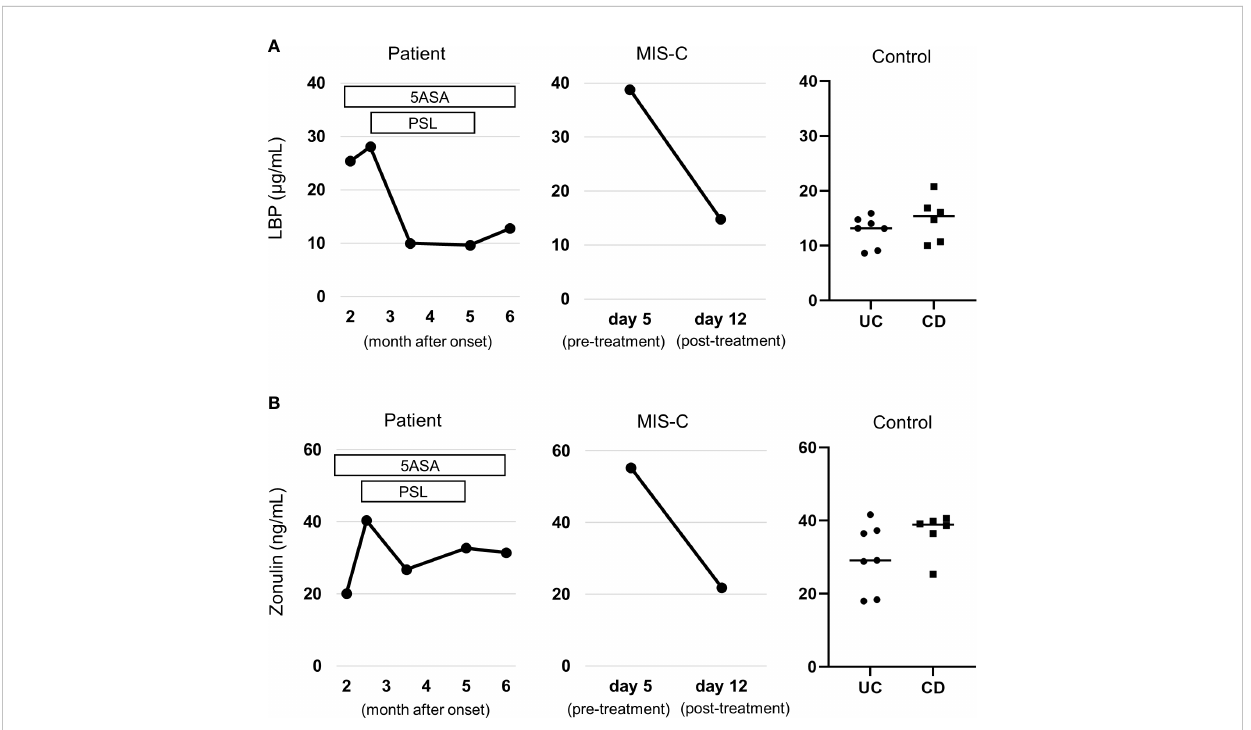
FIGURE 2 Serum gut permeability markers. (A) Changes in serum zonulin. (B) Changes in serum lipopolysaccharide binding protein (LBP). Levels of both markers were compared to those patients with MIS-C as positive control (see reference (13) for details on the clinical course) and patients with in fl ammatory bowel disease in remission as negative control. Note that the patient did not have elevated zonulin through the clinical course, but had elevated LBP, which was normalized by steroid therapy. They were measured by a zonulin (serum) ELISA kit (Immundiagnostik, Bensheim, Germany) and an LBP ELISA kit (Hycult Biotech, Wayne, PA, USA), respectively. 5ASA, 5-aminosalicylate; PSL, Prednisolone; UC, ulcerative colitis; CD, Crohn ’ s disease; MIS-C, multisystem in fl ammatory syndrome in